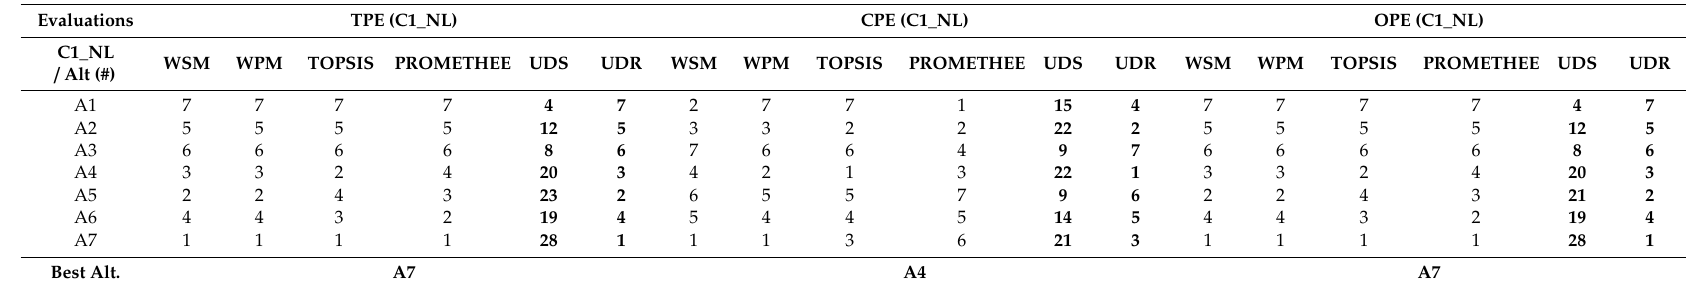
Table 6. Order of the ranks across TPE, CPE, and OPE in C1_NL for 33-bus